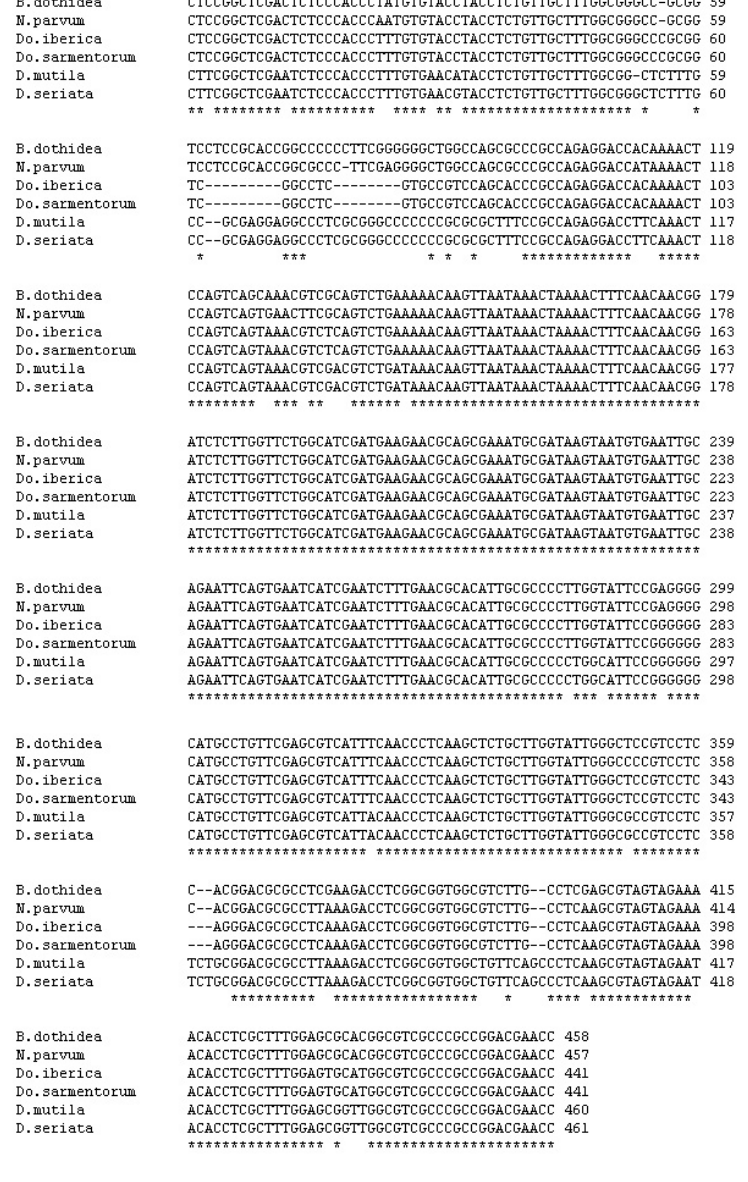
Fig. 3. Multiple alignments obtained with ITS4-ITS5 primers that amplify the nuclear 5.8S rDNA, and its flanking ITS regions (650bp) of Botryosphaeria -like species. In the aligned sequences, asterisk = match, dash =